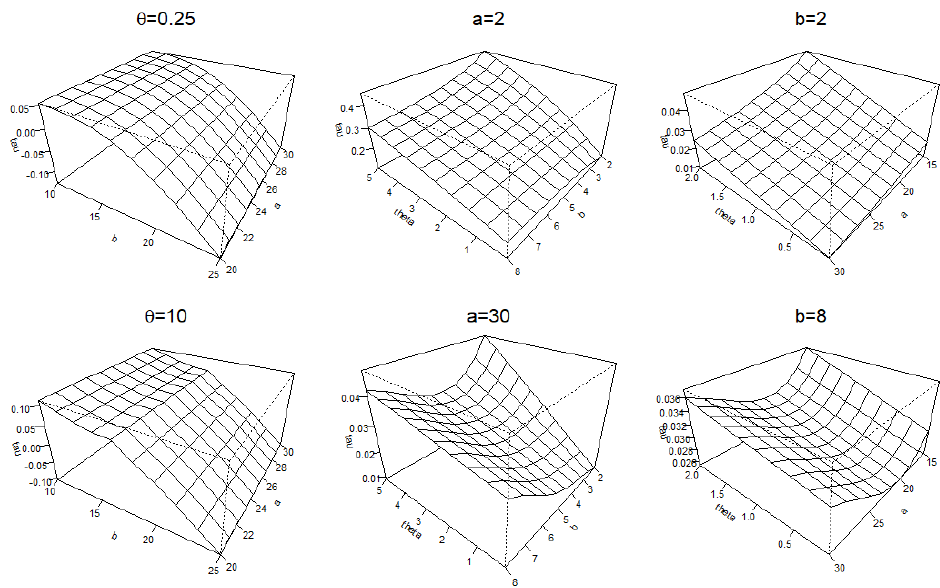
Figure 1. Kendall’s-tau surface plot for the UL-Clayton copula for various parameter